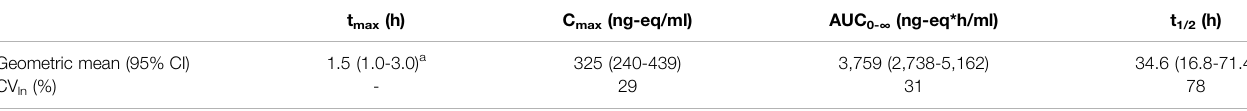
a Data is displayed as median (range). AUC 0- ∞ , area under the plasma concentration-time curve from 0 to in fi nity; CI, con fi dence interval; C max , maximum plasma concentration; CV ln , geometric coef fi cient of variation; t 1/2 , terminal half-life; t max , time to reach maximum plasma concentration.